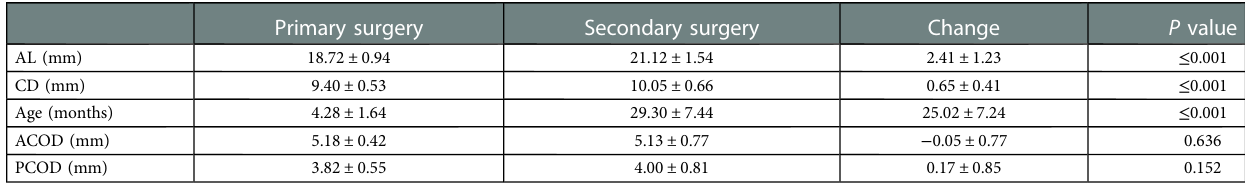
TABLE 3 Mean±standard deviation of ocular parameters collected at the primary and secondary surgery.